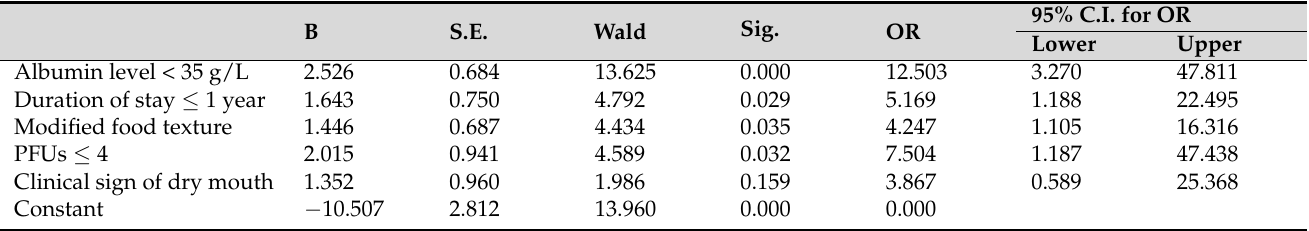
Table 3. Logistic regression analysis of the association between MUAC as outcome variable and PFUs as explanatory variable, while controlling other